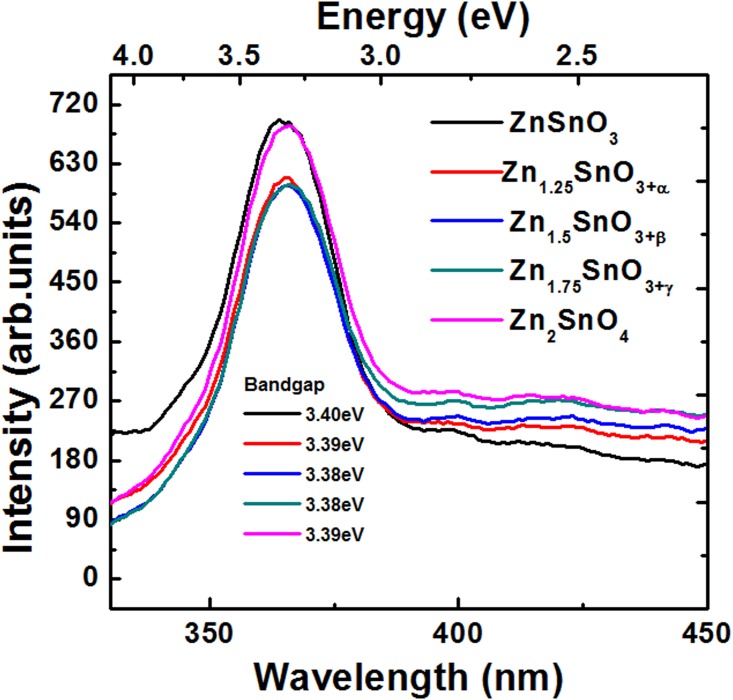
Emission spectra of ZnSnO3, Zn1.25SnO3+α, Zn1.5SnO3+β, Zn1.75SnO3+γ, Zn2SnO4 obtained at the excitation wavelength of 290 nm.